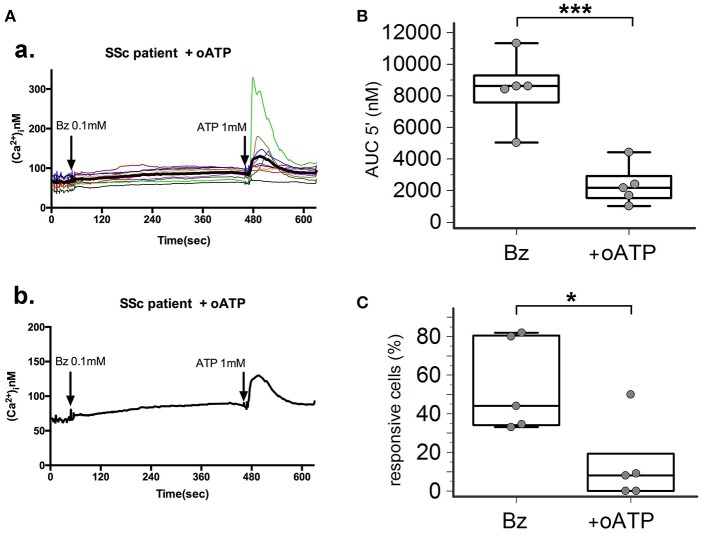
P2X7R antagonism inhibits calcium influx in SSc dermal fibroblasts. Effect of the P2X7R antagonist oxATP (200 μM) on BzATP-induced calcium entry in dermal fibroblasts from SSc patients, as determined by single-cell fluorescence microscopy. (A) Representative plot of an experiment in one SSc patient (a,b). Each colored trace in (a) represents the response of individual cells while the thick black line in (a,b) represent the mean response of all the cells from the same culture dish. The arrow indicates the time when the agonist was added. (B) P2X7-induced Ca2+ influx in dermal fibroblasts from SSc patients (n = 5) pre-incubated with oATP, as assessed by the AUC 5′. ***p < 0.01, two-tailed paired t-test. (C) Percentage of BzATP-responsive cells in SSc patients (n = 5) pre-incubated with oATP. *p < 0.05, two-tailed paired t-test. SSc, Systemic sclerosis; P2X7R, P2X7 receptor; Bz, 2′-3′-O-(4-benzoylbenzoyl)ATP; oATP, oxidized ATP; Ca2+, calcium; AUC 5′, area under the curve represents the area enclosed between the curve of the [Ca2+]ìvs. the time for 5 min after the addition of the stimulus.